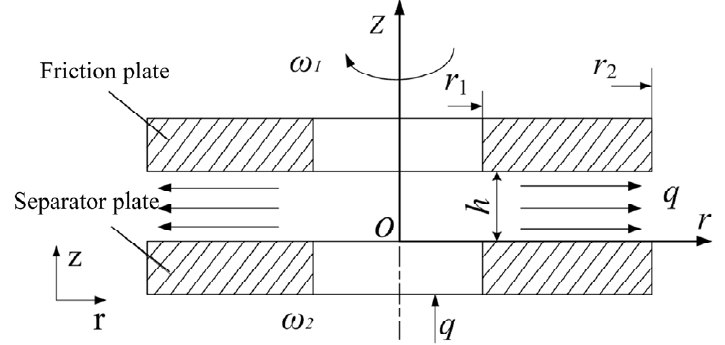
Figure 4. Simplified model for friction pair.